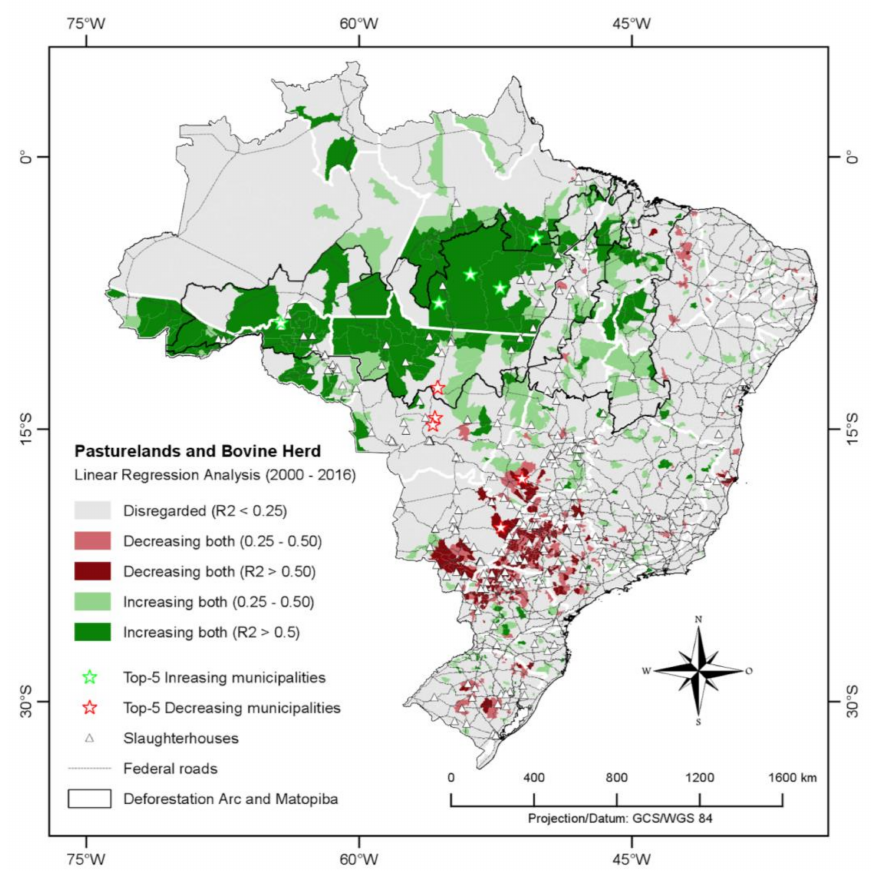
Figure 9. The expansion (green colors) and retraction (red colors) zones of the Brazilian livestock activity, produced through several linear regression models between the MODIS based pasture areas and the cattle animal unit at the municipality level (available at: http://maps.lapig.iesa.ufg.br/?layers=